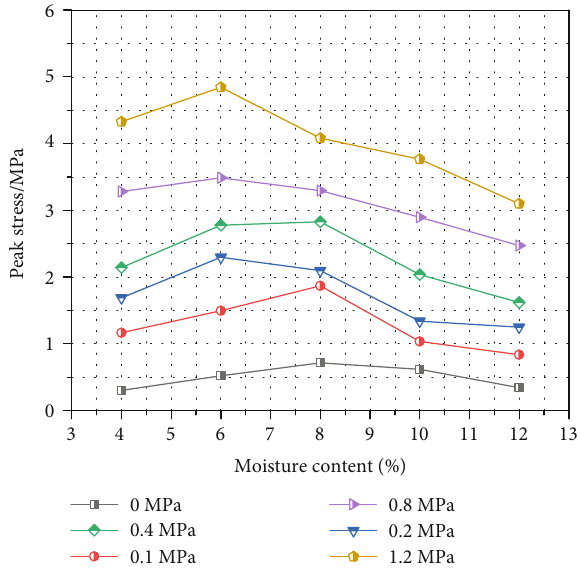
Figure 4: Relationship between peak stress and moisture content under di ff erent con fi ning